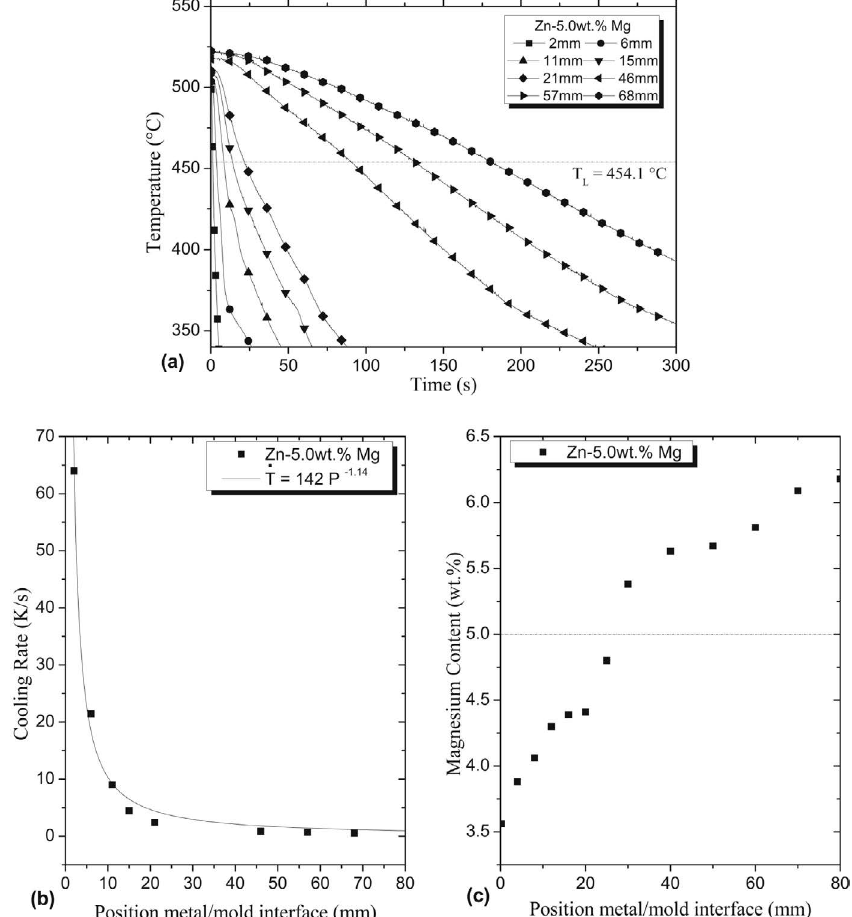
Figure 2. (a) Experimental cooling curves; The numbers in the label, represent the position of the thermocouples (P) from the cooled bottom of the casting (P=0); (b) Cooling rate as a function of (P); (c) Mg concentration profile along the length of the vertical DS casting.